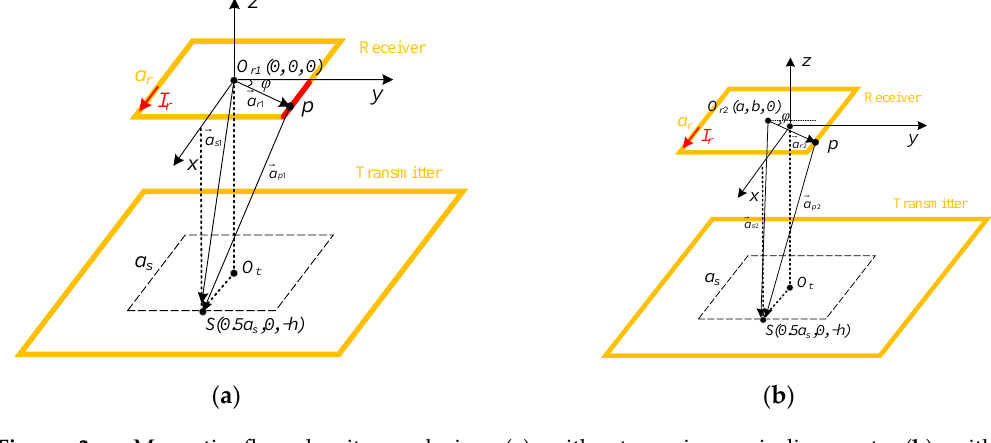
Figure 3. Magnetic flux density analysis: ( a ) without receiver misalignment; ( b ) with receiver misalignment.